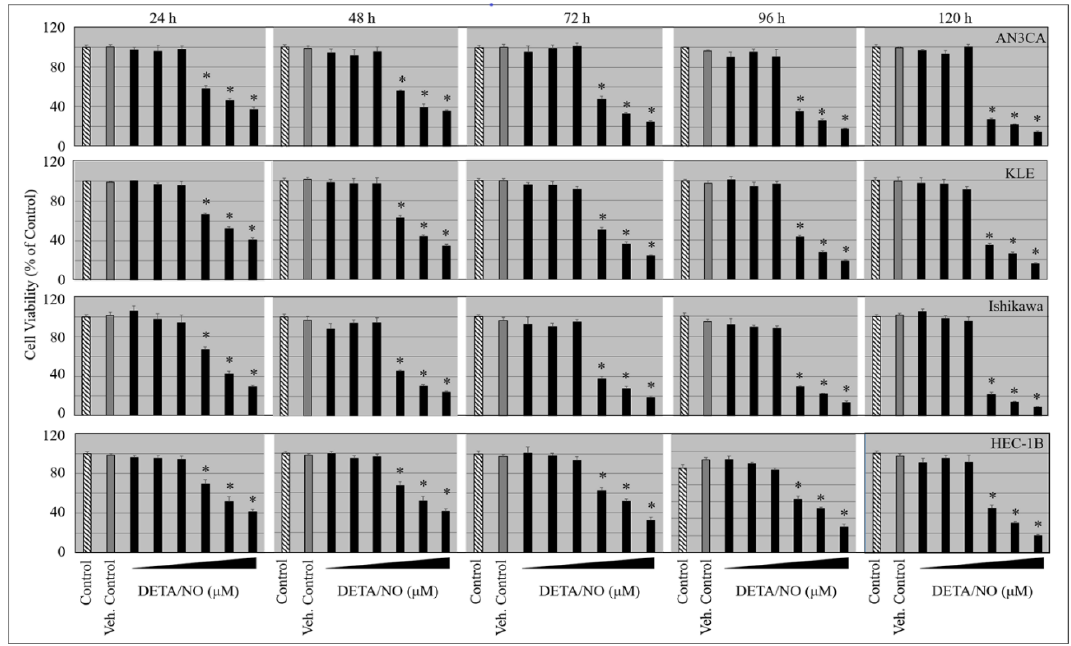
Figure 1. DETA / NO attenuated growth of endometrial cancer cells. Endometrial cancer cells were treated with various doses of DETA / NO (37.1, 62.5, 125, 250, 500, and 1000 µ m) every 24 h for 120 h and cell viability was measured by MTS assay. Results represent the average of six wells expressed as the percentage of untreated controls (mean ± SEM). * p < 0.05 is statistically significant between the control and treatment groups.